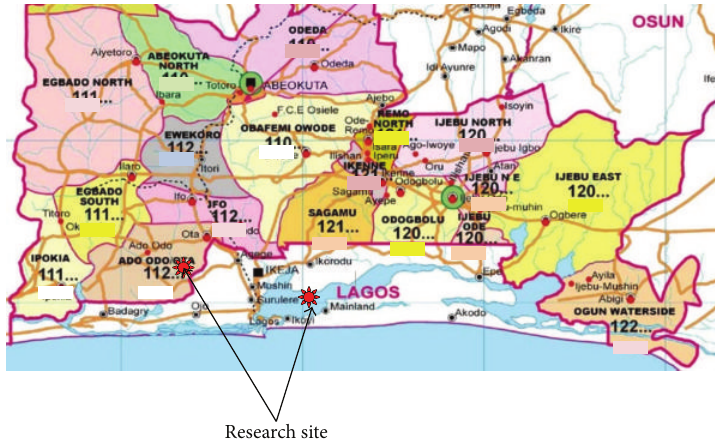
Figure 2: Location of study coastal